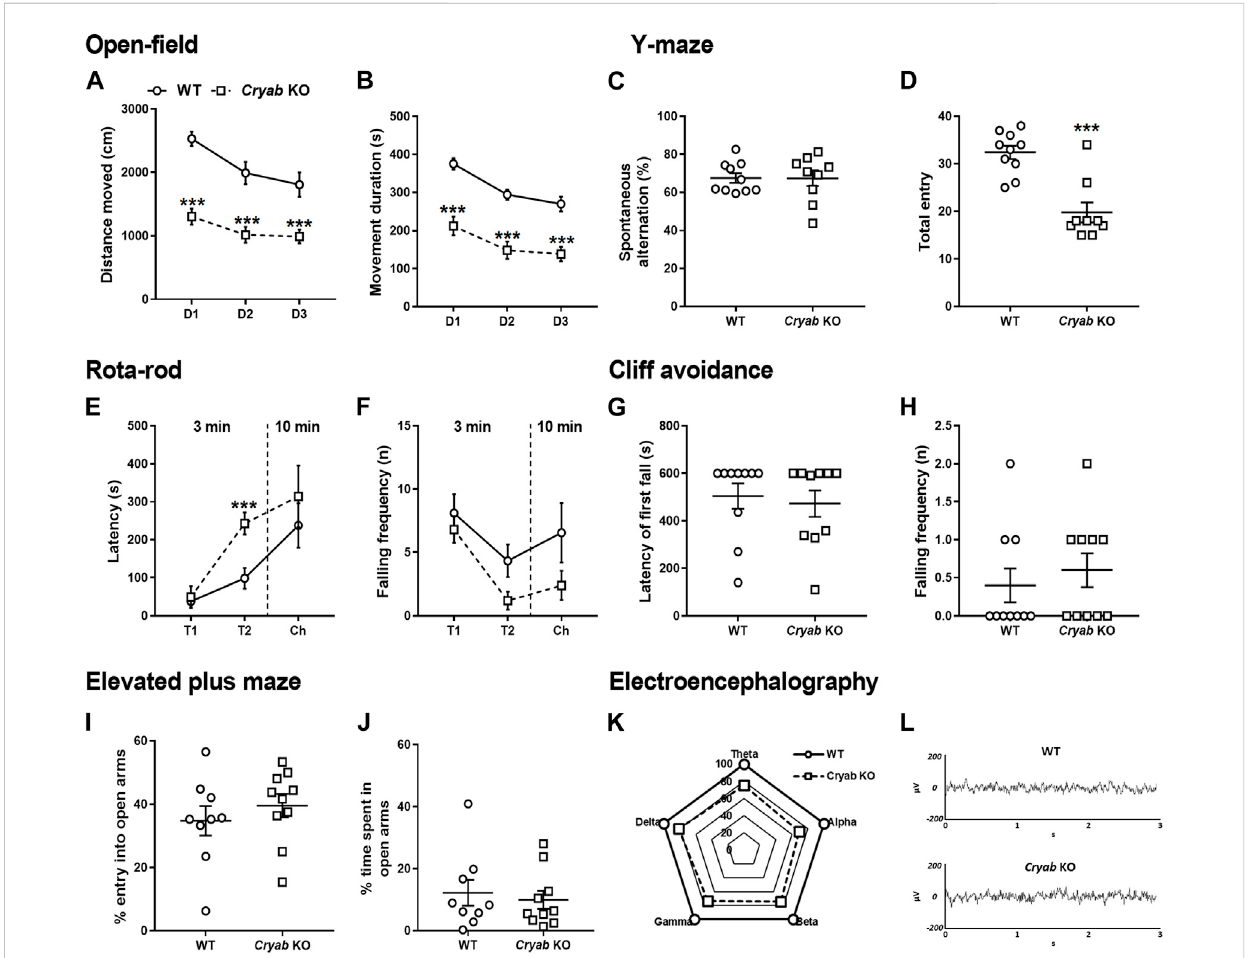
FIGURE 2 General behavior of wild-type (WT) and Cryab knockout (KO) mice. At 5 – 7 weeks old, pups were tested for their baseline behaviors. The open- fi eld test shows the locomotor activity indicated by (A) distance moved (cm) and (B) movement duration (s) recorded for 10 min over three consecutive days. Y-maze indicates short-term memory in terms of (C) spontaneous alternating behavior (%) and (D) total entries. Latency of fi rst fall (s) and falling frequency (n) in the (E,F) rota-rod and (G,H) cliff avoidance tests determine motor balance/coordination and impulsive tendencies, respectively. Anxiety is measured by the (I) percentage entry (%) and (J) percentage time spent (%) in the open arms in the elevated maze plus test. (K) Baseline electroencephalogram(EEG)resultsrevealsthepowerofdelta,theta,alpha,beta,andgammainmice,recordedfor2 h(drug-free). (L) SampleEEGtraces shows a 2-s activity during a 2-h recording. Data expressed as mean ± S.E.M., except (K) and (L) . n = 9 – 10. *** p < 0.001 (vs. WT; Bonferroni post hoc analysis or t